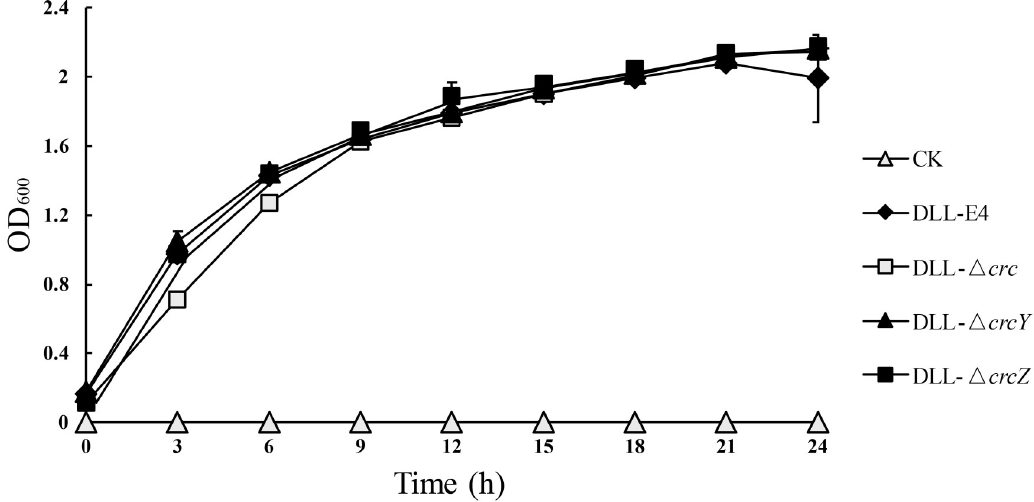
Fig 2. The growth of P . putida DLL-E4, DLL- Δ crc , DLL- Δ crcY , and DLL- Δ crcZ on LB medium. CK: control group, no inoculate any cells, to test whether the culture medium and operation are completely sterile. The values are the means of the results from three biological replicates with standard deviations. Statistical analysis indicates no differences in the growth rate among the four strains, P >